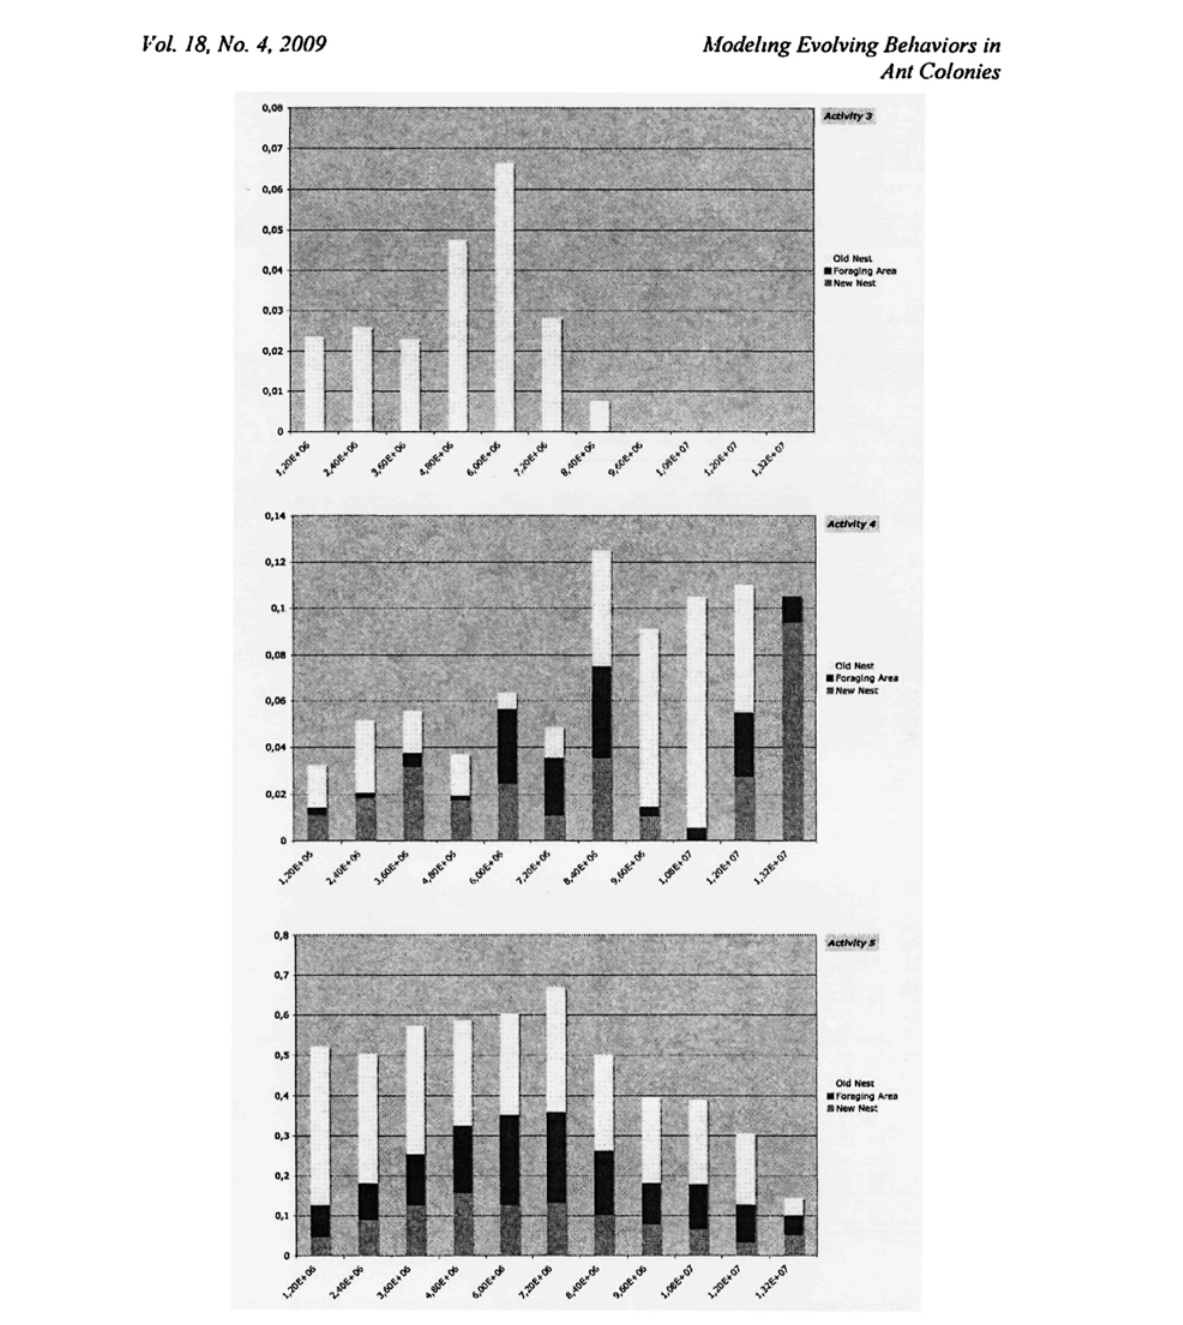
Fig. 5: Activity analysis: evolution of the number of individuals involved in the activities Aj...A s . Each histogram bin is proportional to the number of individuals acting such activity in a 20 minutes window. The bins arc subdivided according to the number of individuals that arc present in the old nest, the foraging area or the new